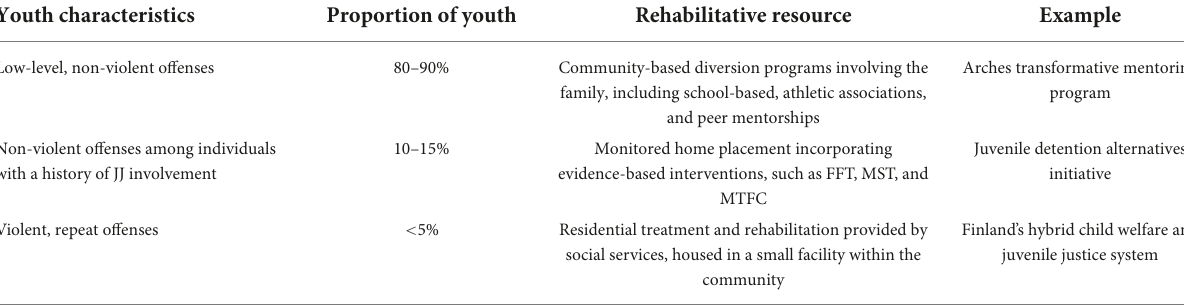
TABLE 1 Alternatives to juvenile incarceration for all youth through the age of 25